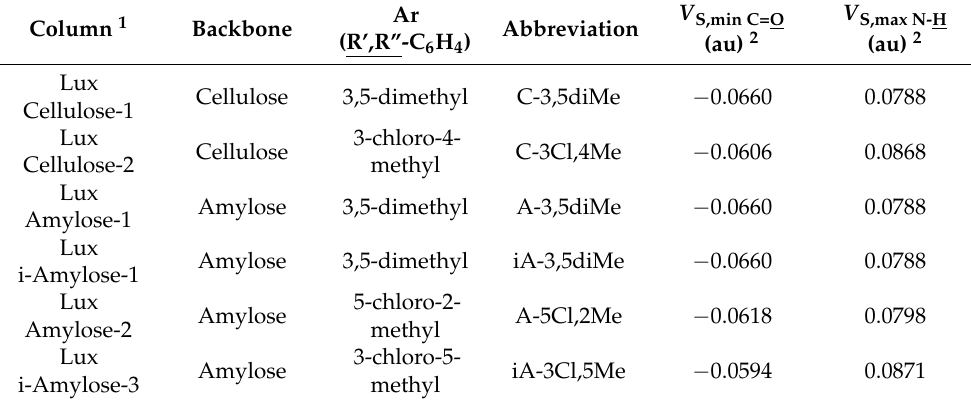
Table 1. Structure of the six polysaccharide-based chiral stationary phases (CSPs) used in the study. Column